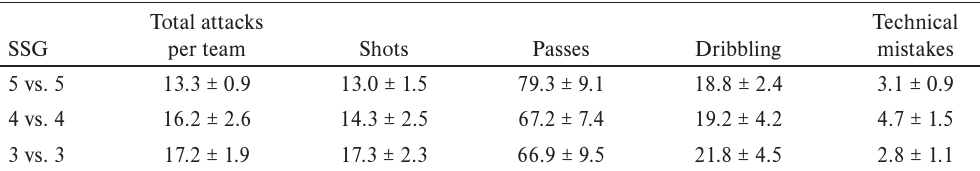
Note. SSG = small sided